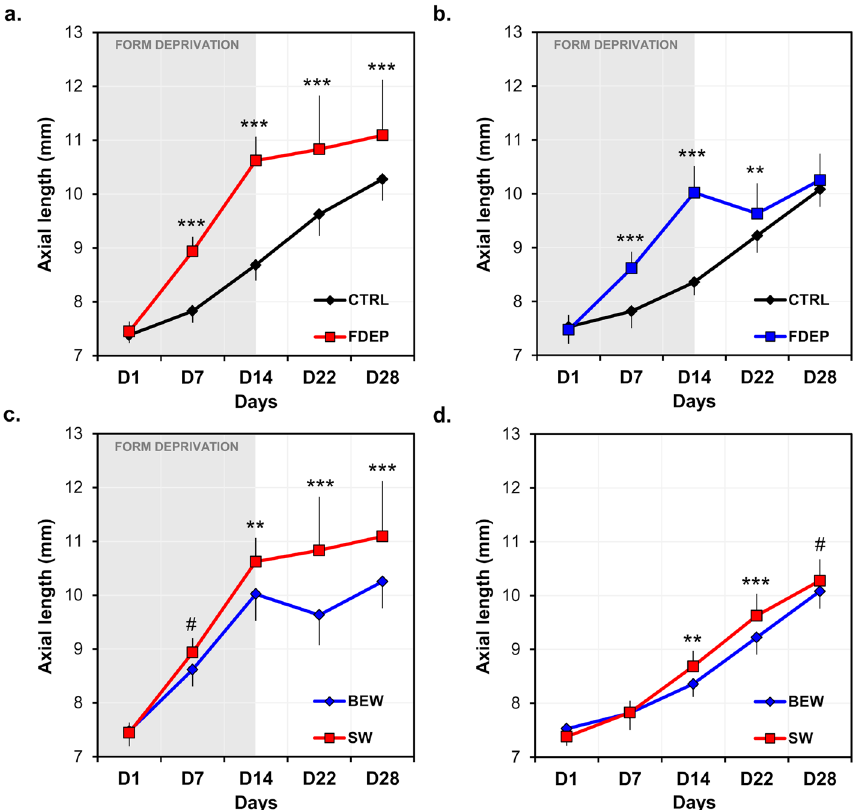
Figure 3. Axial length of FDEP and control eyes in animals reared under BEW (n = 18) or SW (n = 18) lights. After 14 days of form-deprivation, AL was increased in FDEP eyes compared to control eyes in the SW ( a ) and BEW ( b ) groups (P < 0.001). Two weeks following form-deprivation (D28), the AL of FDEP eyes was no longer different from control eyes in chicks reared under BEW light but not in animals reared under SW light ( a , b ). FDEP eyes of animals raised under BEW light displayed shorter AL compared FDEP eyes of animals raised under SW light (P < 0.001) ( c ). BEW attenuated axial elongation due to form-deprivation observed on D14 ( P = 0.002) ( c ). Control eyes reared under BEW light displayed shorter AL than eyes reared under SW light on D14 and D22 ( P = 0.002 and P < 0.001, respectively) ( d ). Data are represented as average ± SD. Post hoc pairwise comparison significance: # P < 0.1; * P < 0.05; ** P < 0.01; *** P <